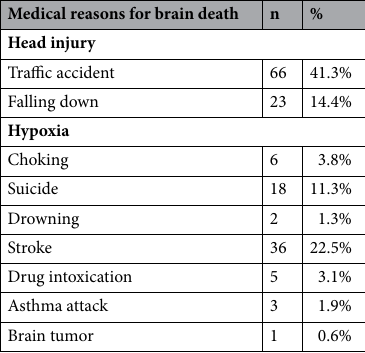
Table 1. Medical reasons for brain death of deceased donors in pancreas